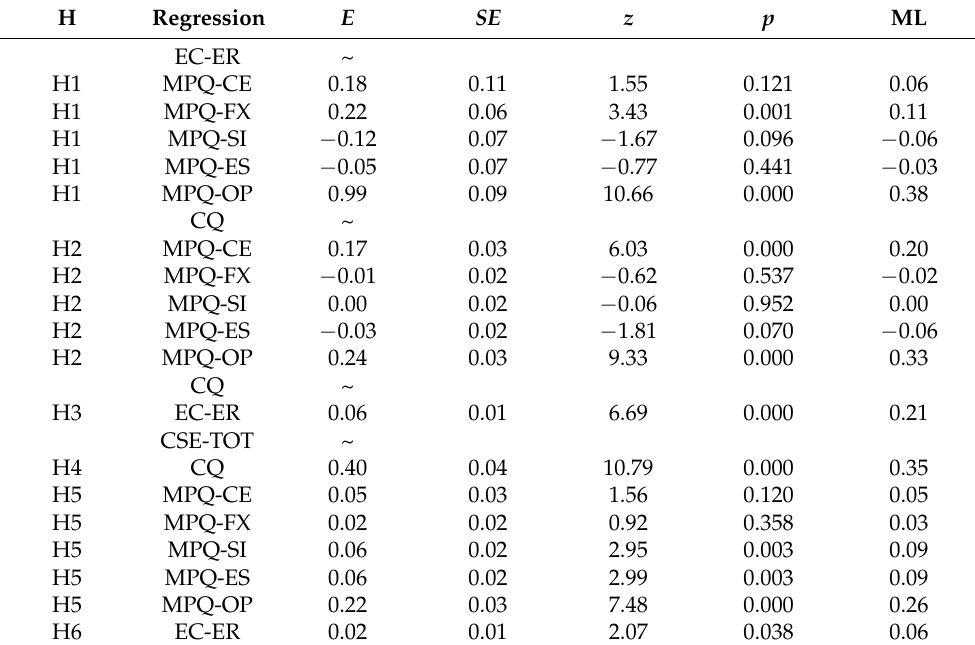
Table 2. Regressions from model